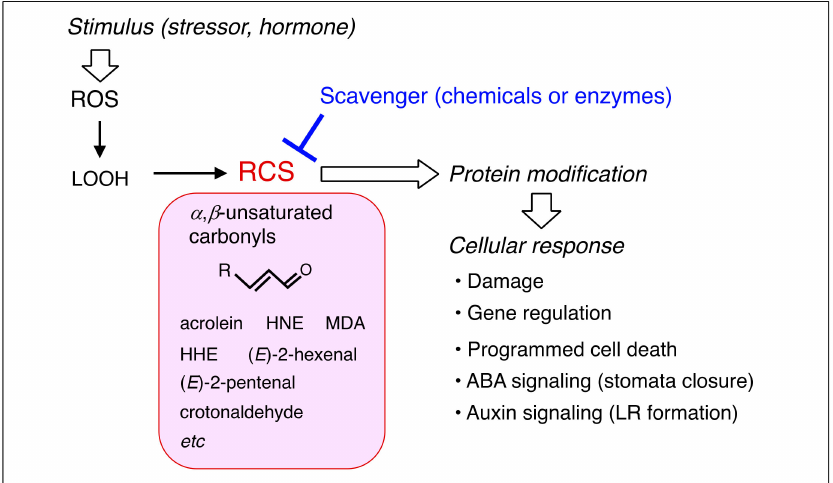
Figure 1. Involvement of reactive carbonyl species (RCS) in reactive oxygen species (ROS) signaling. The involvement is validated by the scavengers’ e ff ects to suppress both RCS levels and a ROS-initiated phenomenon. ABA, abscisic acid; HNE, 4-hydroxy-( E )-2-nonenal; HHE, 4-hydroxy-( E )-2-hexenal, MDA, malondialdehyde; LR, lateral